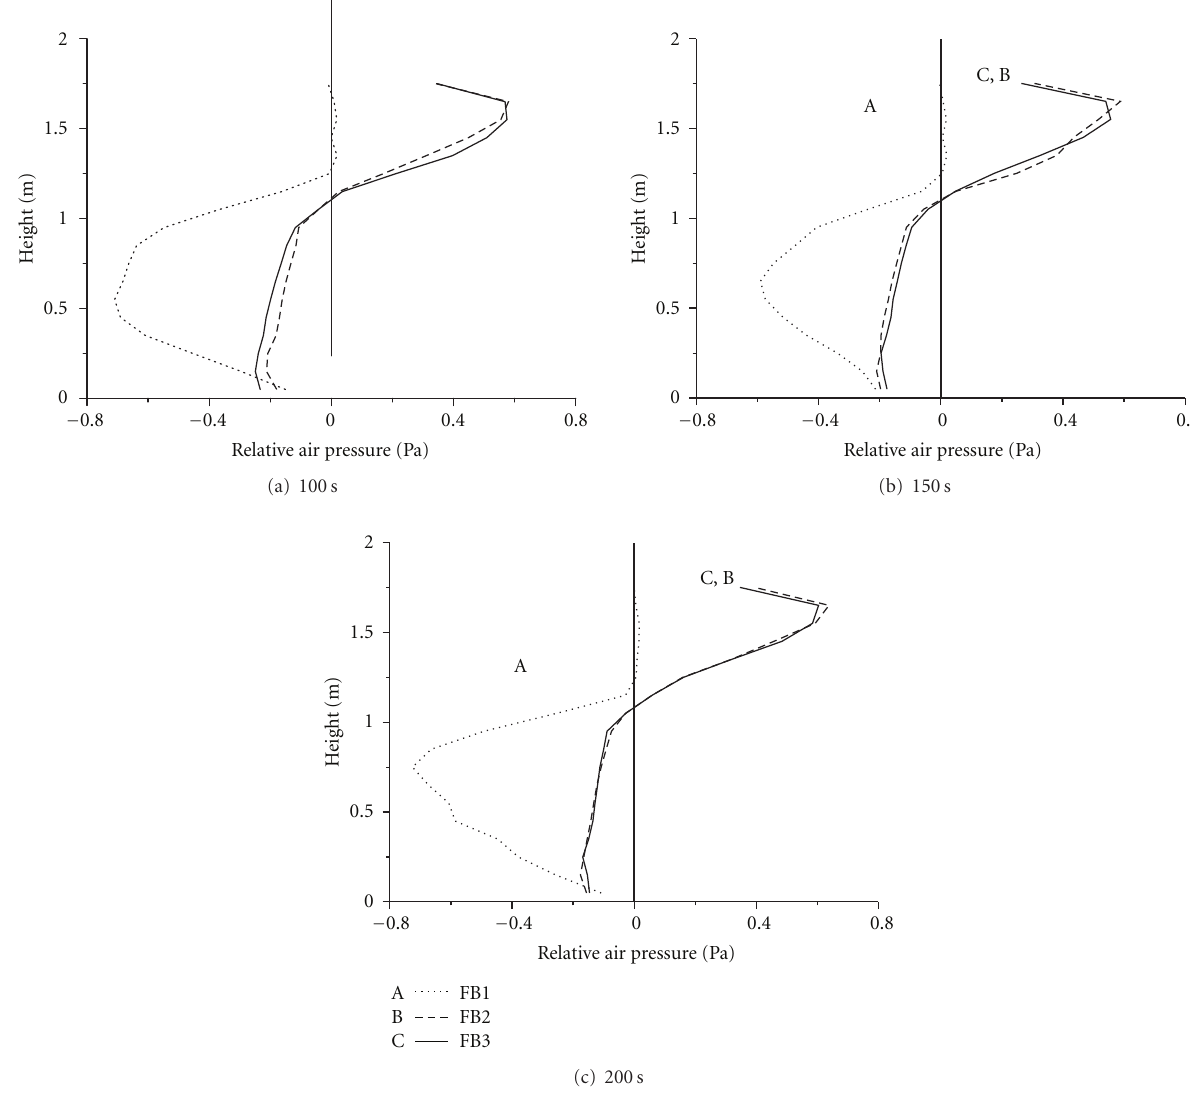
Figure 9: Relative air pressures at